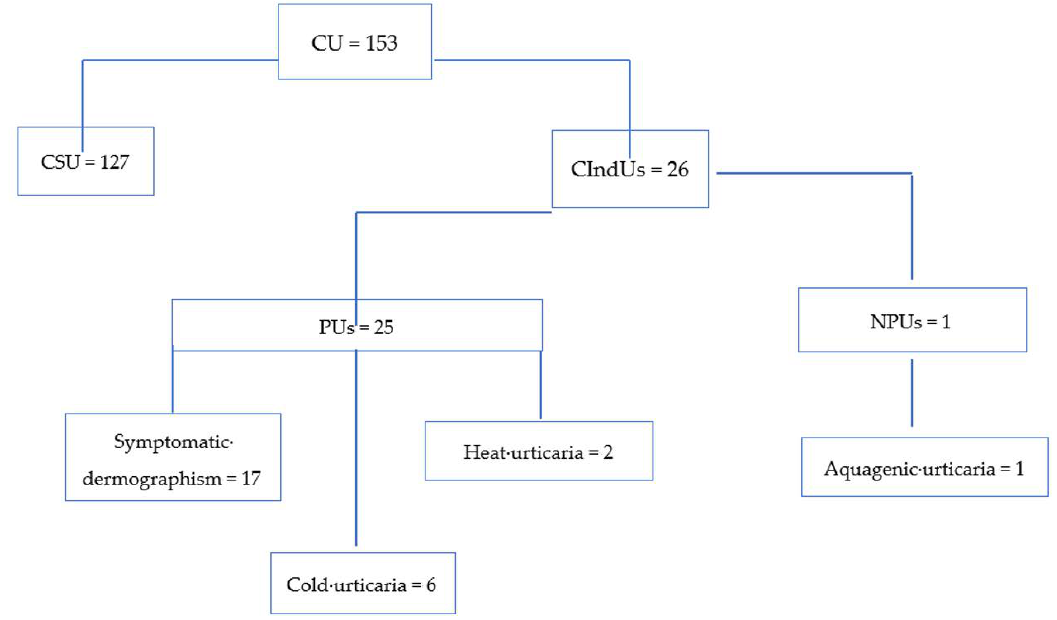
Figure 1. Diagnostic flowchart of elderly patients with chronic urticaria (CU). PU: physical urticarias; NPU: nonphysical urticarias; CIndUs: chronic inducible urticarias; CSU: chronic spontaneous